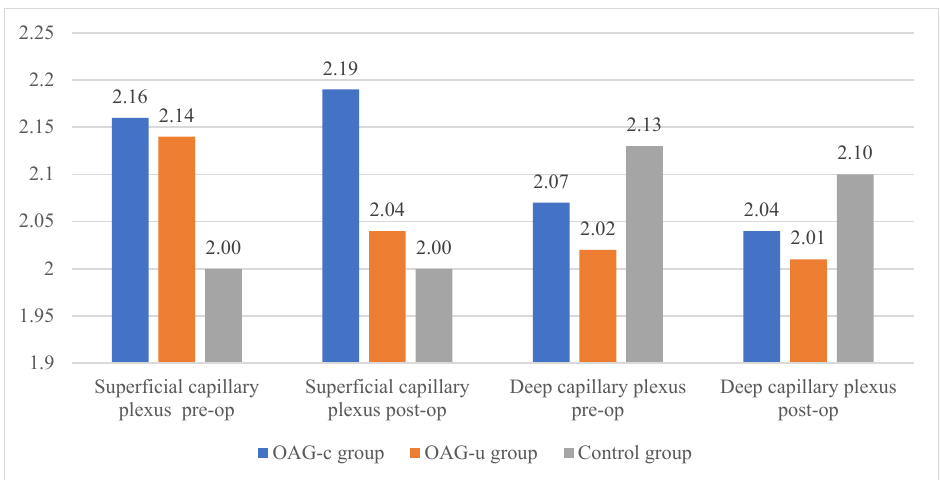
Figure 9. Comparison of posterior segment OCT results in ETDRS–9 subsegments and retinal layers